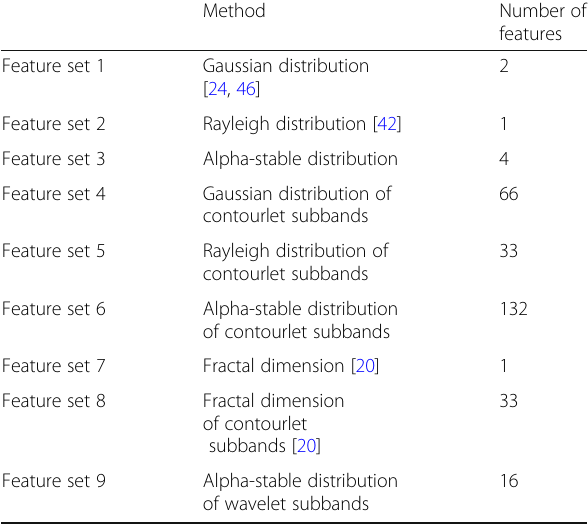
Table 1 Used feature sets in our